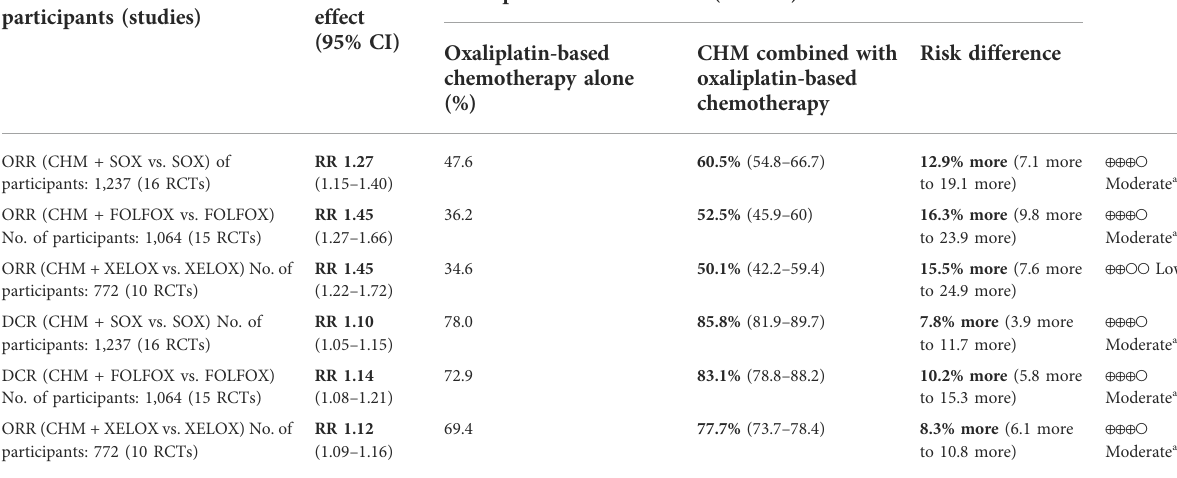
TABLE 5 Summary of fi